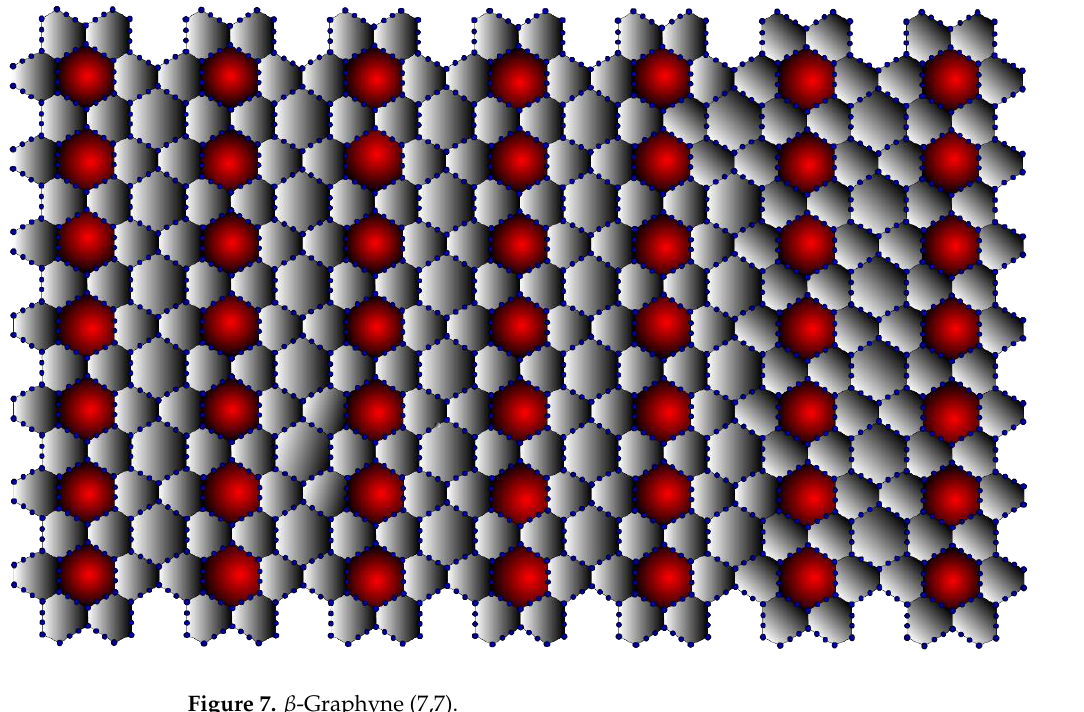
Figure 7. β -Graphyne (7,7). Figure 7. 𝛽 - Graphyne (7,7) Table 7. Partition Table for 𝛽 - Graphyne Table 7. Partition Table for β - .Edge types